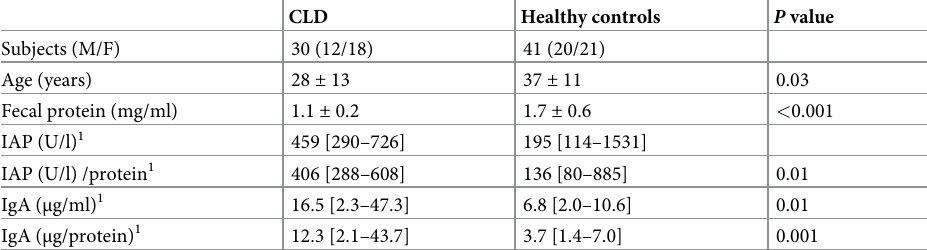
Table 1. Levels of fecal biomarkers in congenital chloride diarrhea (CLD) and healthy controls. CLD Healthy controls P value Subjects